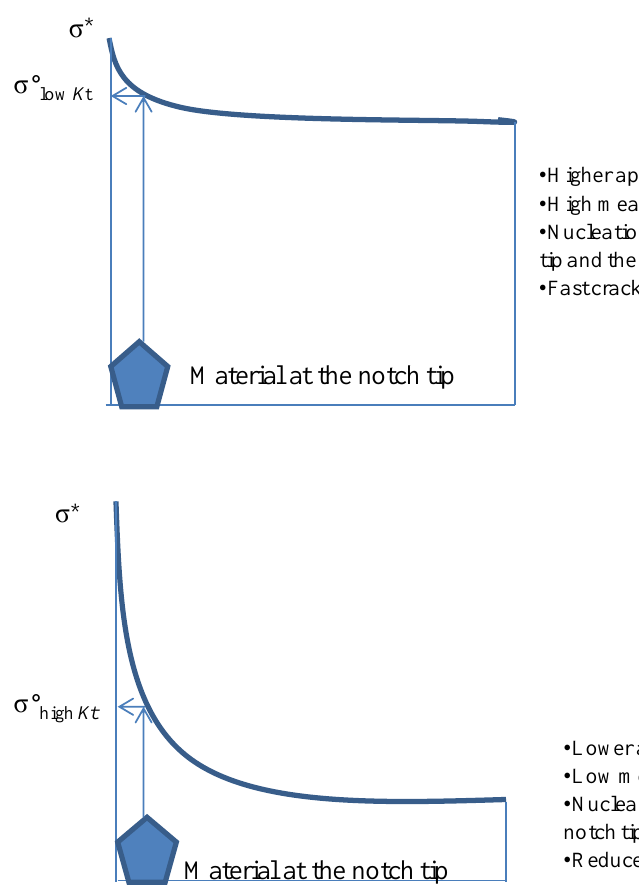
Figure 15. Crack nucleation and propagation: stress gradient and environmental